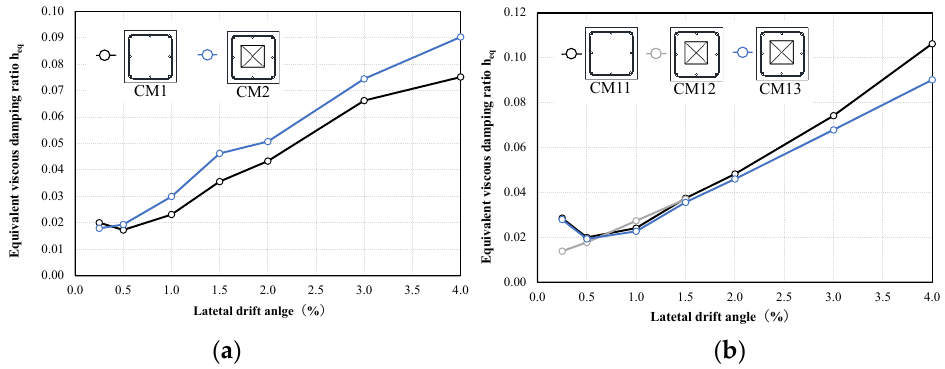
Figure 12. Equivalent viscous damping ratios: ( a ) N-series; ( b ) S-series.